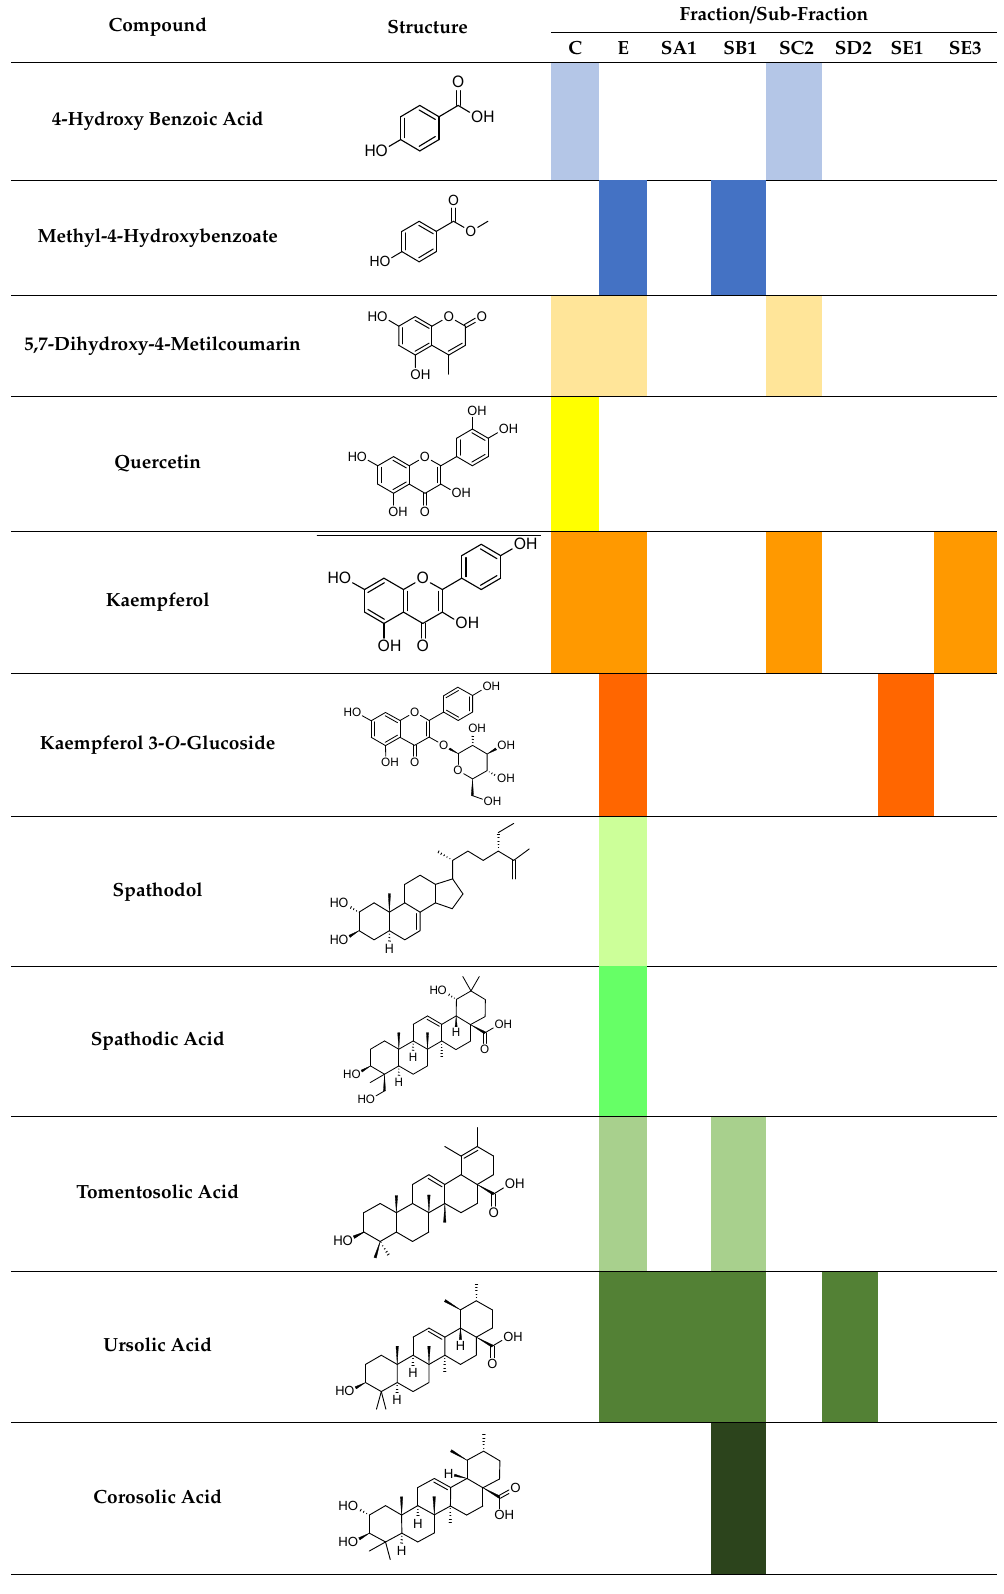
Table 2. Chemical structures of the identified compounds and their distribution in the active fractions and sub-fractions of Spathodea campanulata